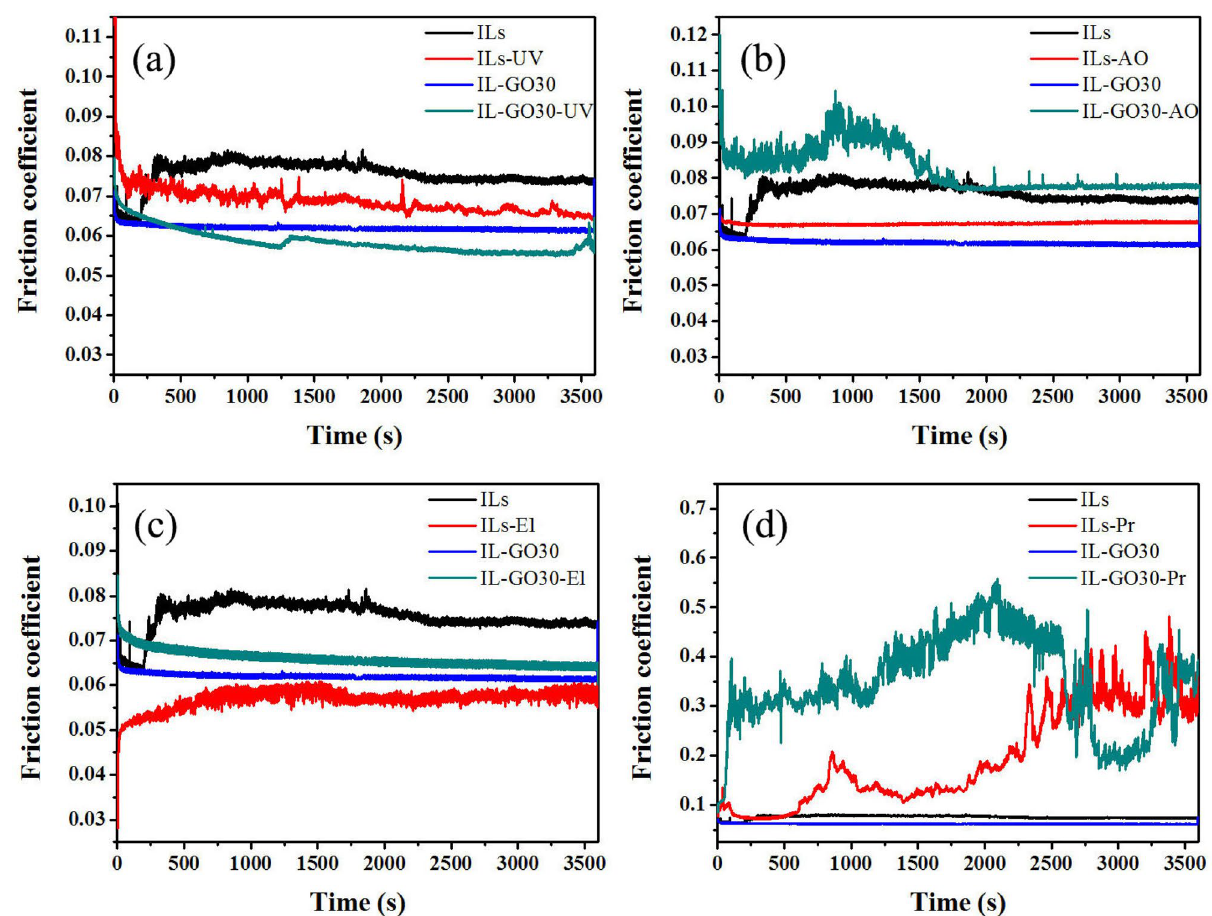
Figure 1. Comparison of the tribological behaviors of the composite coatings of steel/ILs, steel/IL-GO30 sliding against a steel ball under high vacuum condition. ILs and IL-GO30 represent the friction coefficients of the sample before irradiation. ILs-UV (or AO, El, Pr) and IL-GO30-UV (or AO, El, Pr) represent the friction coefficients of the sample after balls were measured using an optical microscope (STM6, Olympus). After friction tests, the wear depth and wear track profiles were determined by a noncontact three-dimensional surface profiler (model Micro MAXTM, ADE